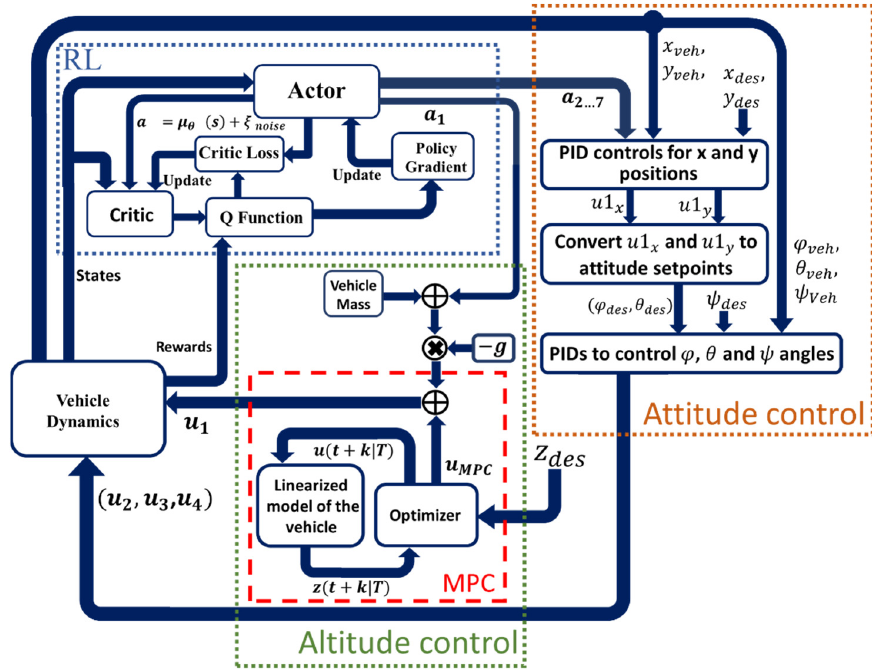
Figure 5. The architecture of the proposed adaptive RL-based controller.